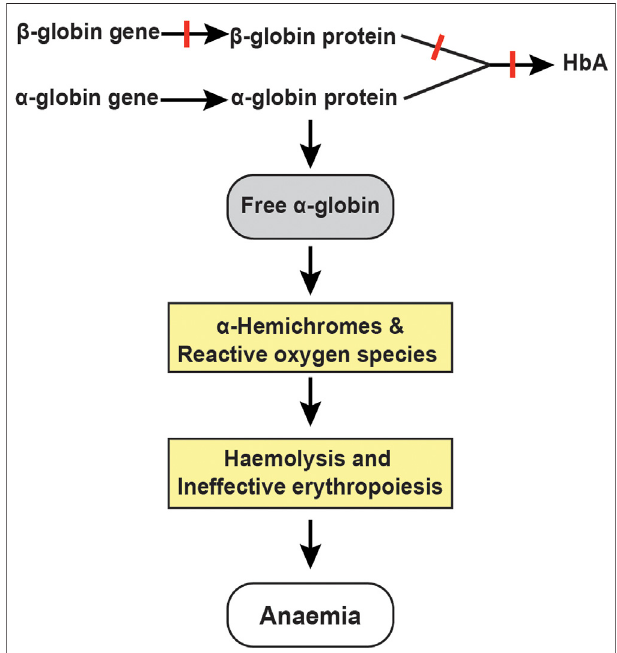
FIGURE 1 | Pathophysiology of β -thalassemia. Absent or reduced β -globin production leads to an unbalanced excess of α -globin chains, which trigger a cascade of events through the generation of α -hemichromes and reactive oxygen species resulting in haemolysis and ineffective